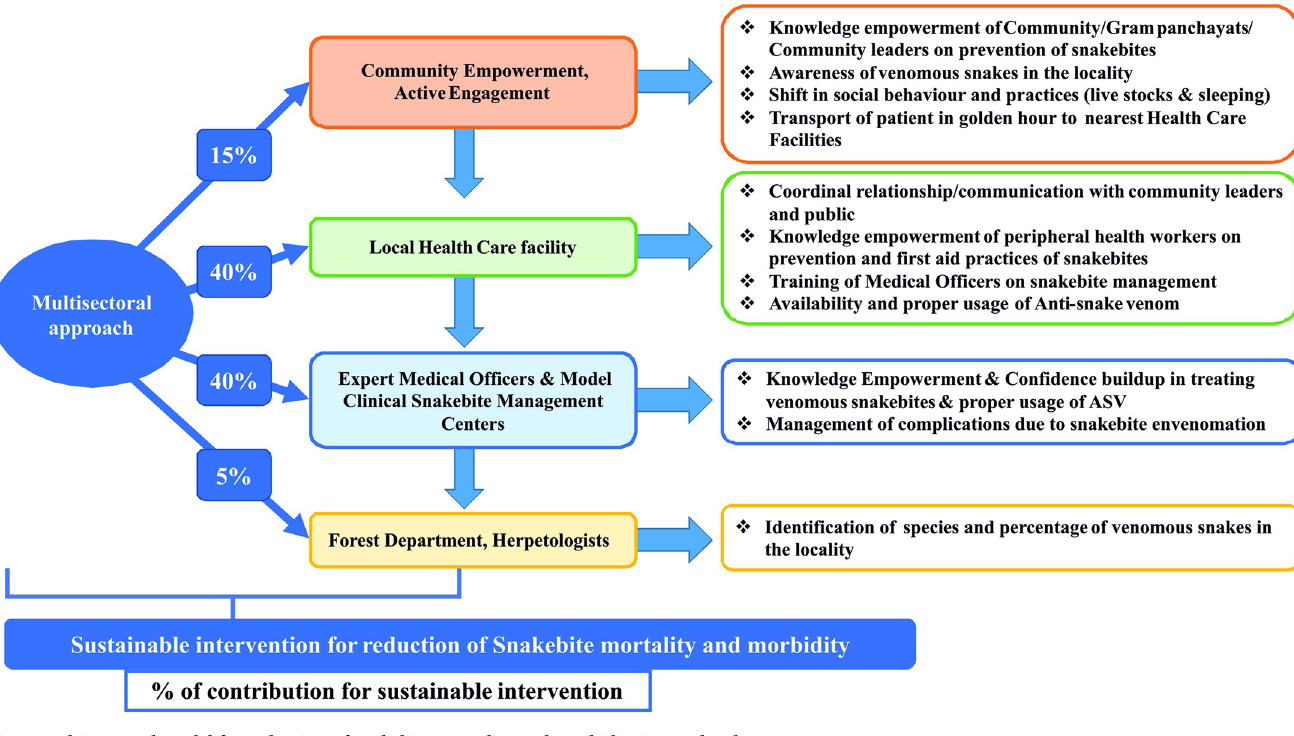
PLOS ONE | https://doi.org/10.1371/journal.pone.0255657 August 5,